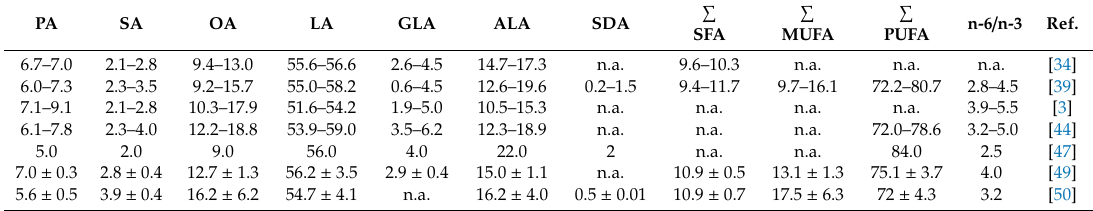
Table 3. Hempseed fatty acid profile (% of